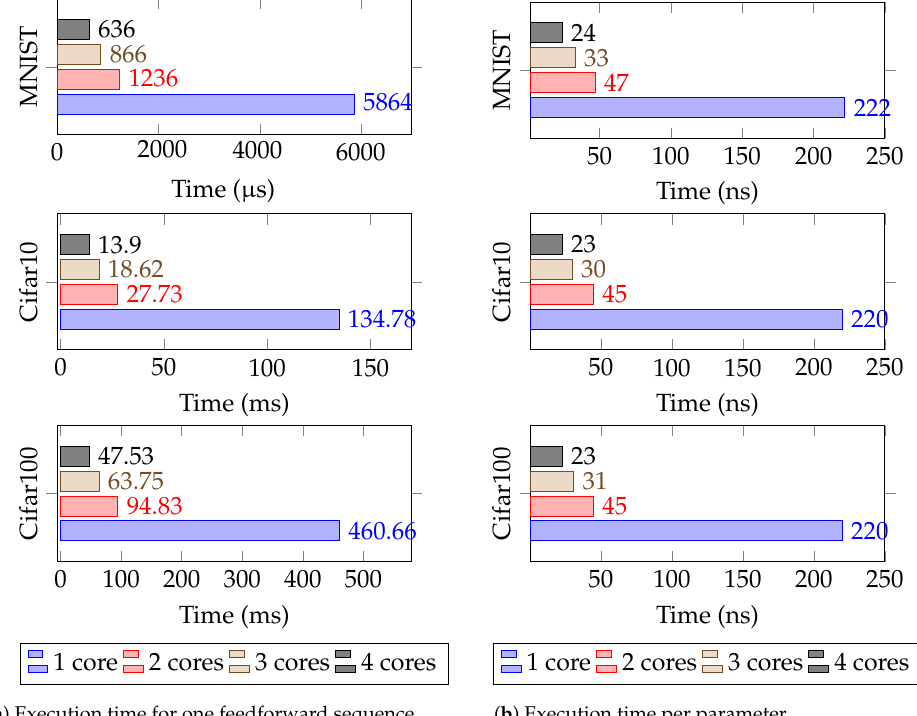
Figure 7. Tests results of the NNP with different numbers of cores and topologies: ( a ) Execution time for one feedforward sequence, ( b ) Execution time per